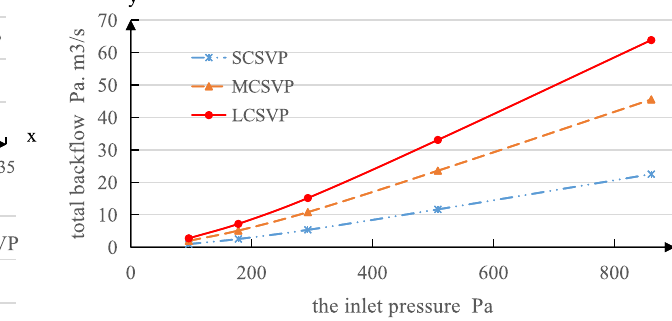
Fig. 19. Effects of inlet pressure on total back fl ow.